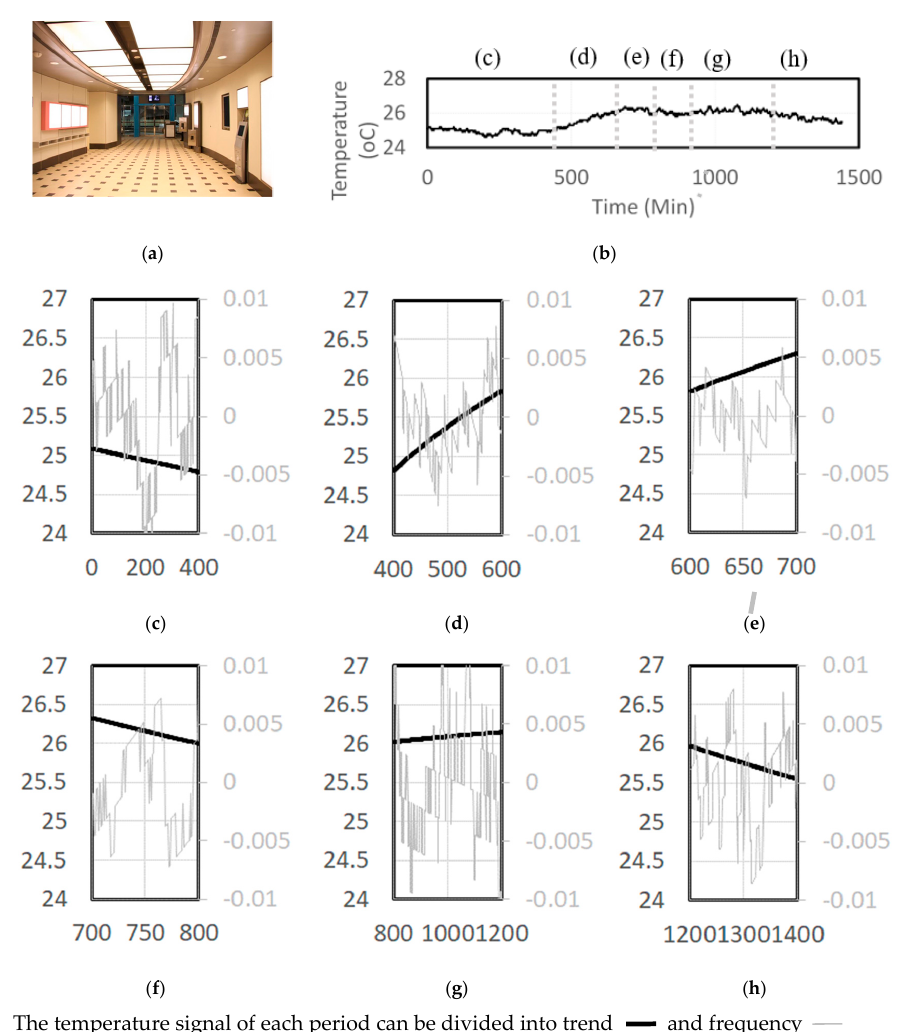
Figure 3. The test site simulation and related parameters for building a control model.